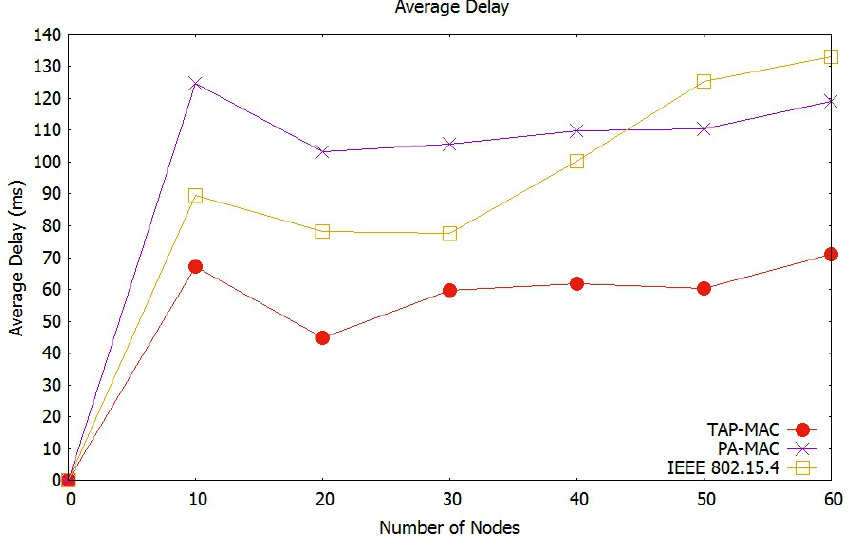
Figure 12. Scenario 2: Average network